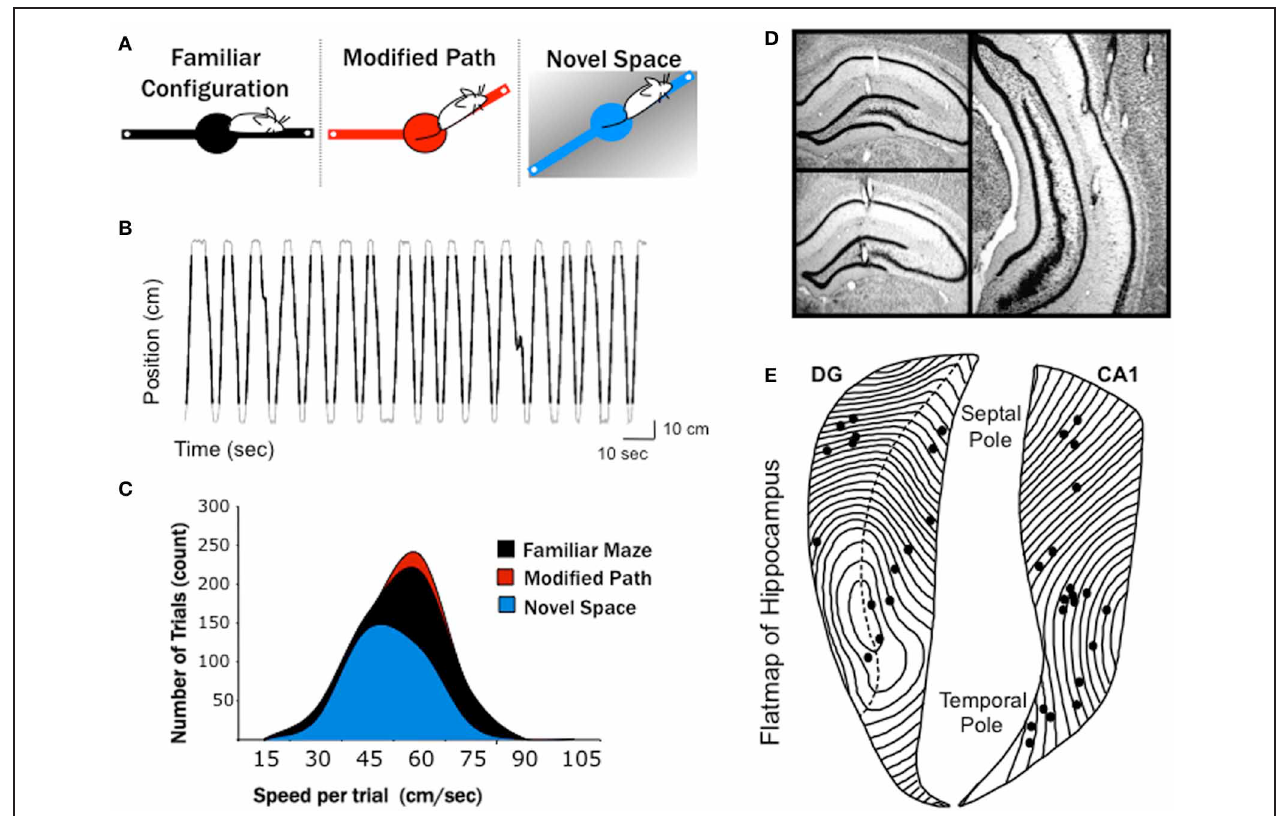
FIGURE 1 | Experimental conditions and electrode positions. (A) A series of three, 10-min recordings were obtained from each rat over a 4 days period in: (1) in familiar space, (2) along a modified path in familiar space, and (3) in novel space. The black (familiar), red (modified), and blue (novel) color codes are maintained in all figures to differentiate conditions. The familiar maze configuration consisted of a finely textured linear track placed in a generally white room. On the following day the rats where placed on a modified path in the same room, with one arm altered 30 ◦ . Two days later (following 1 day of retraining on the familiar configuration) the rats were run on a coarsely textured linear track in a novel space. (B) The position of a rat along the 140-cm linear track over time during 33 consecutive trials is shown. Black lines overlaid on the gray trace indicate the portion of each track traversal that